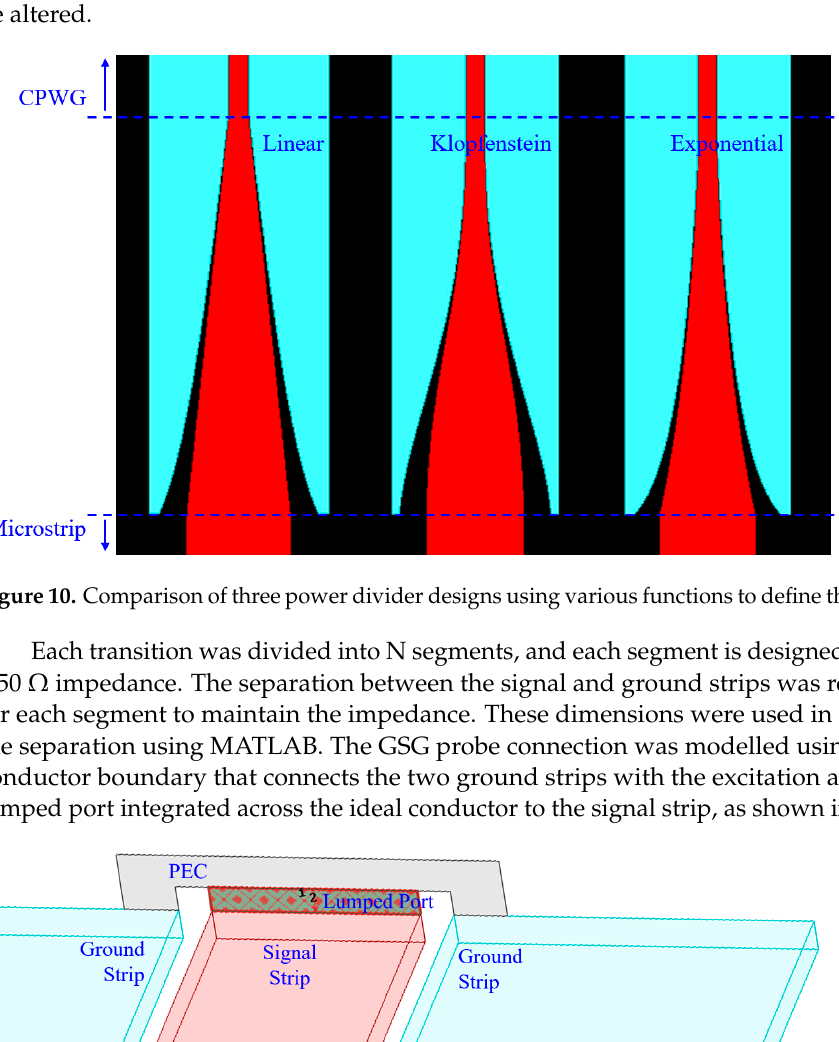
Figure 11. Ground–signal–ground probe modelling in HFSS.